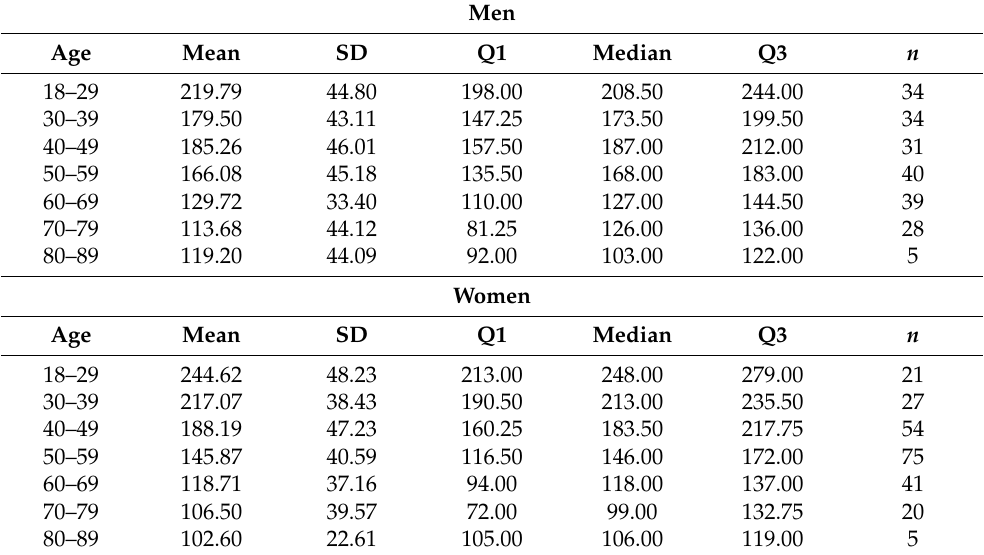
Figure 4. Box plots of the L1 trabecular attenuation (HU) measurements in the soft tissue window (ST) of the study sample ( n = 454) grouped by sex (F, female, red boxes; M, male, blue boxes) and by age (the width of the boxes is proportional to the sample size, the height of the boxes represent the distance between the first and third quartiles, the whiskers extend from either side of the boxes represent the ranges for the bottom 25% and the top 25% of the data values, and the outliers are marked with an asterisk on the boxes in each group). Table 3. L1 trabecular attenuation (HU) in the soft tissue window for men ( n = 211) and women ( n = 243) grouped by age.